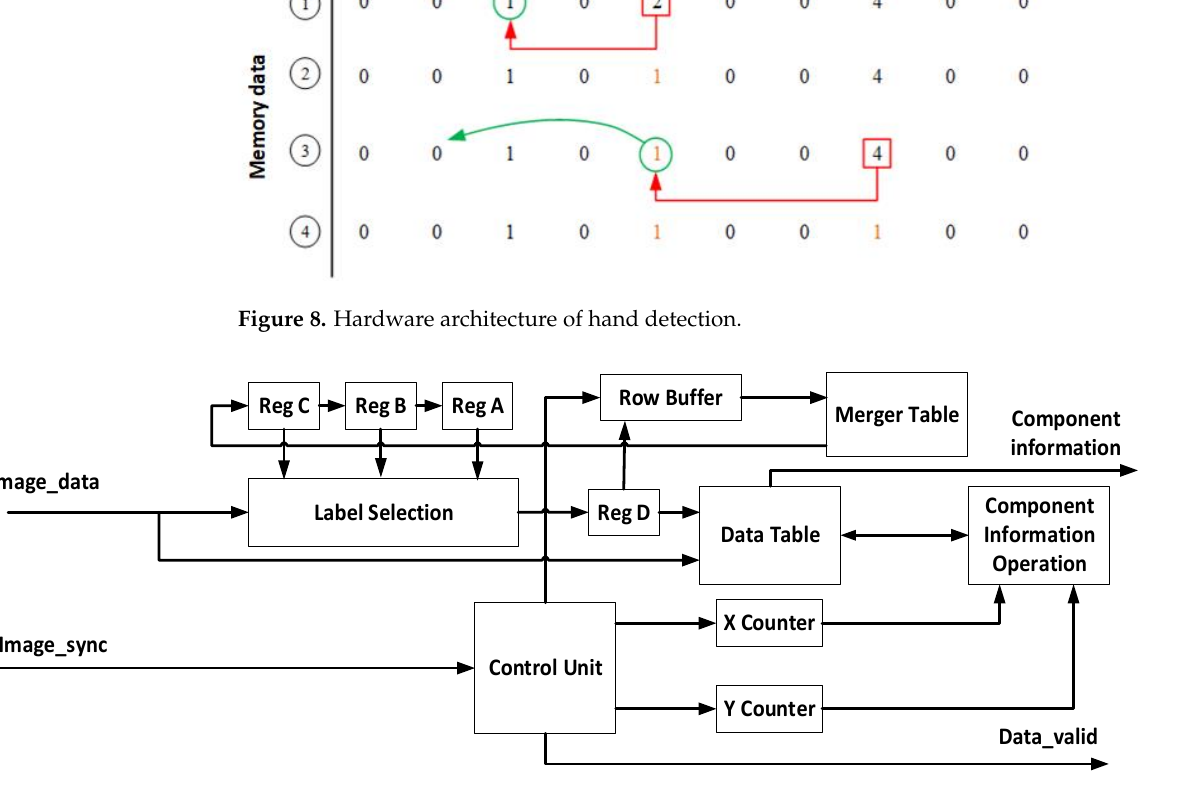
Figure 9. Hardware architecture of object labeling.